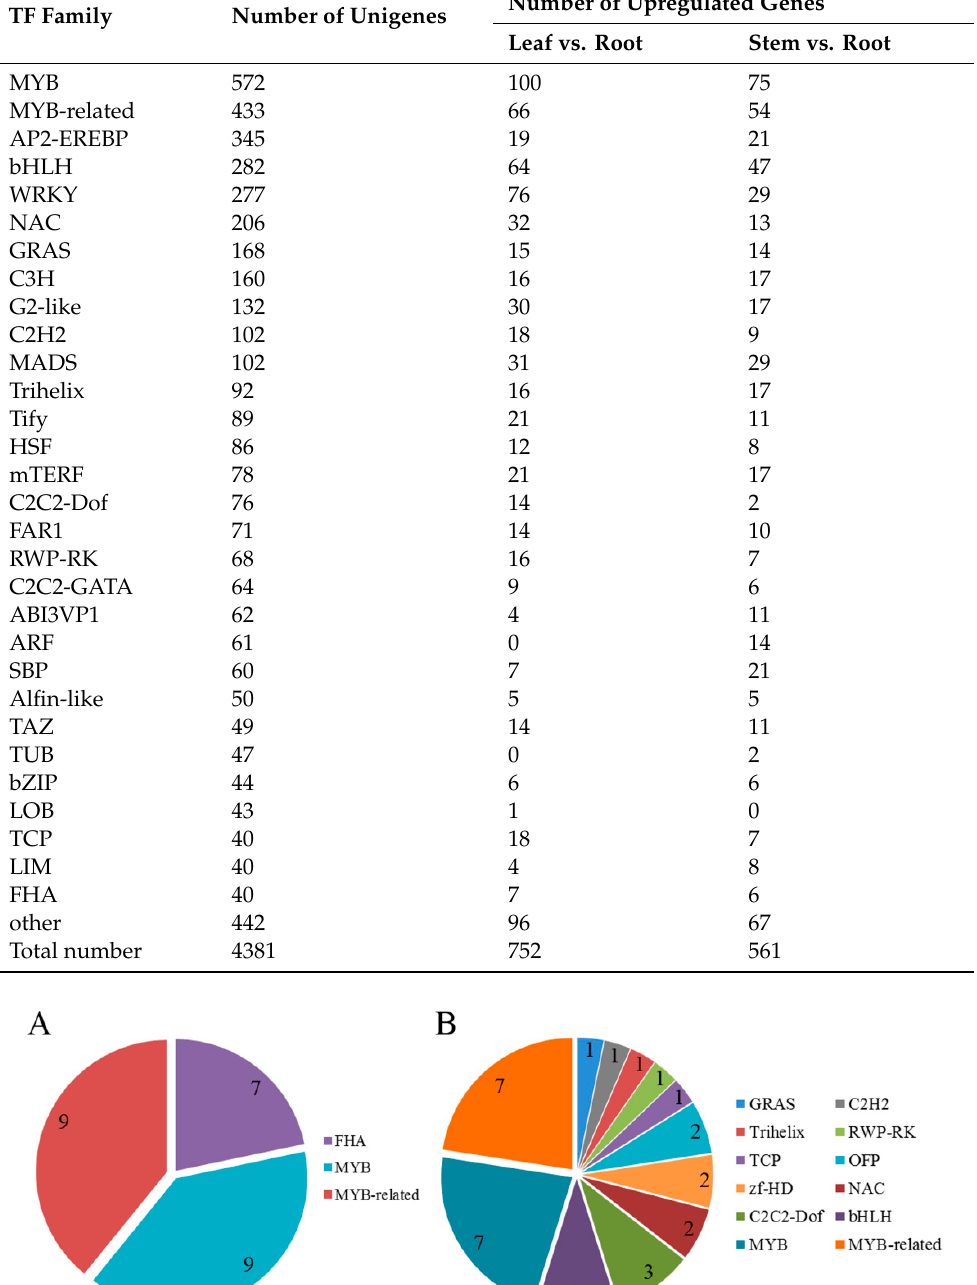
Table 4. Classification and number of TF families identified in the DEGs database of C. chinense.